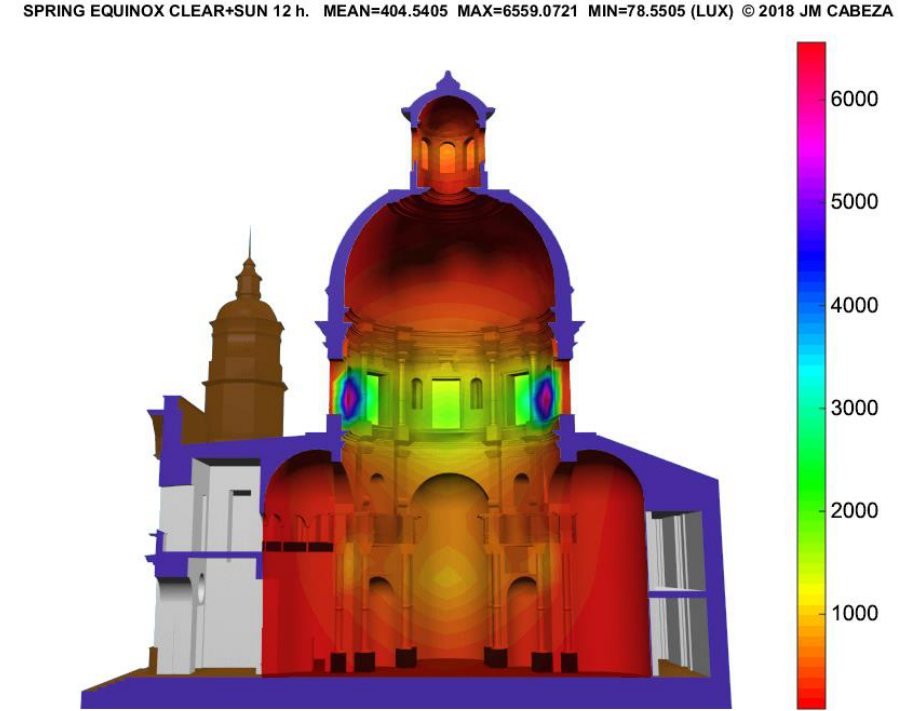
Figure 7. Daylight section on the 21st of March, on a sunny day at noon. Values near 300 lux at the lower points. Source: Cabeza-Lainez.